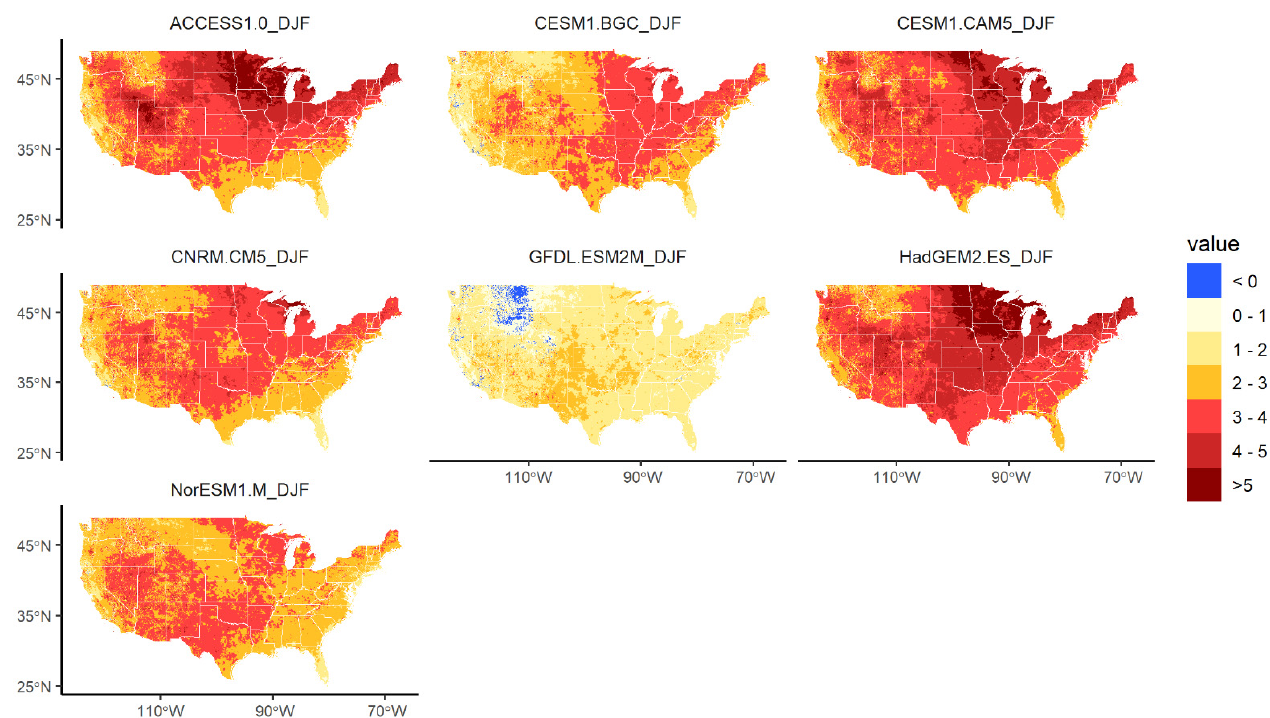
Figure A4. The projected change in winter (December through February) average maximum temperature rates (°C) for each climate projection selected for analysis under RCP 4.5 described in Table A2.